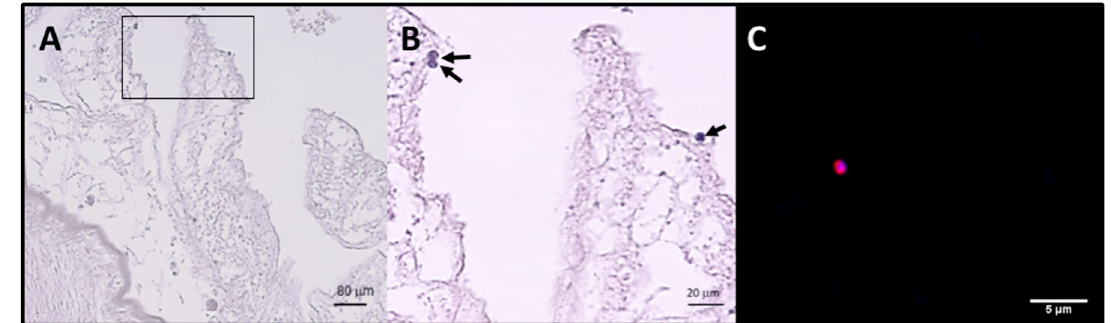
Figure 2. Stained sections of the intestinal tract of one Scomber scombrus (Ss VII 4BO) infected by the genotype Cryptofish7 ( A ) Presence of round bodies suggestive of the developmental stages of Cryptosporidium spp. observed in the apical position of a (stained with H&E) ( B ) Detail of A (delimited area). ( C ) Structure labelled in red with the Sporoglo (Waterborne) antibody and blue with DAPI (4 ′ ,6-diamidino-2-phenylindole) suggestive of an intracellular stage of Cryptosporidium spp.